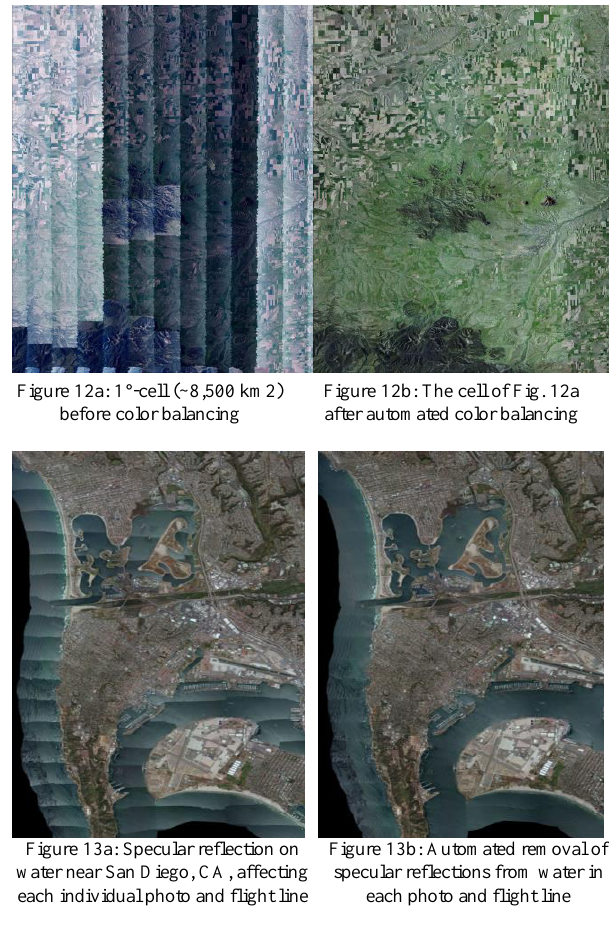
Figure 13a: Specular reflection on water near San Diego, CA, affecting each individual photo and flight line